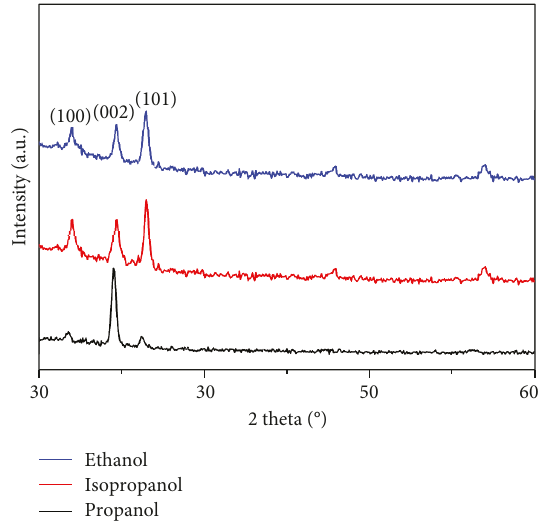
Figure 1: X-ray di ff raction patterns of ZnO thin fi lms synthesized with various